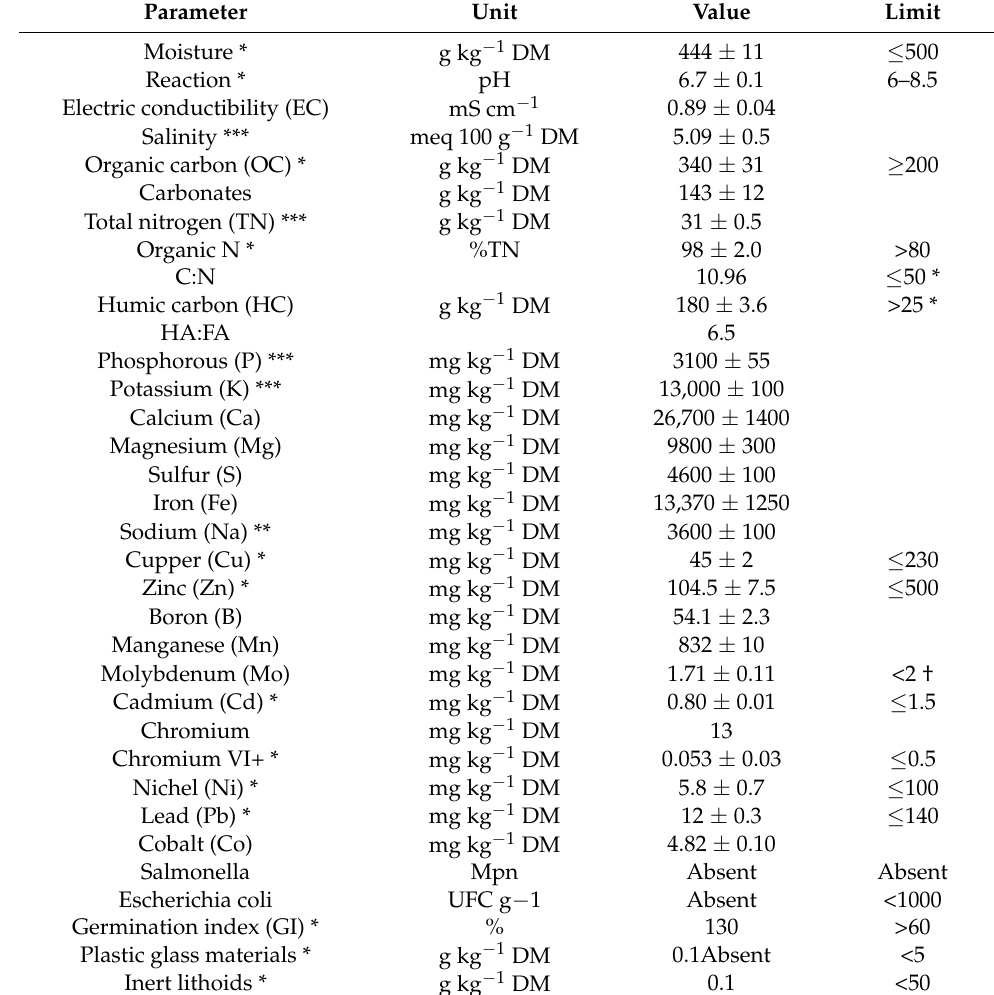
Table 1. Physical, chemical, and biological characteristics of the wood-based compost (mean ±